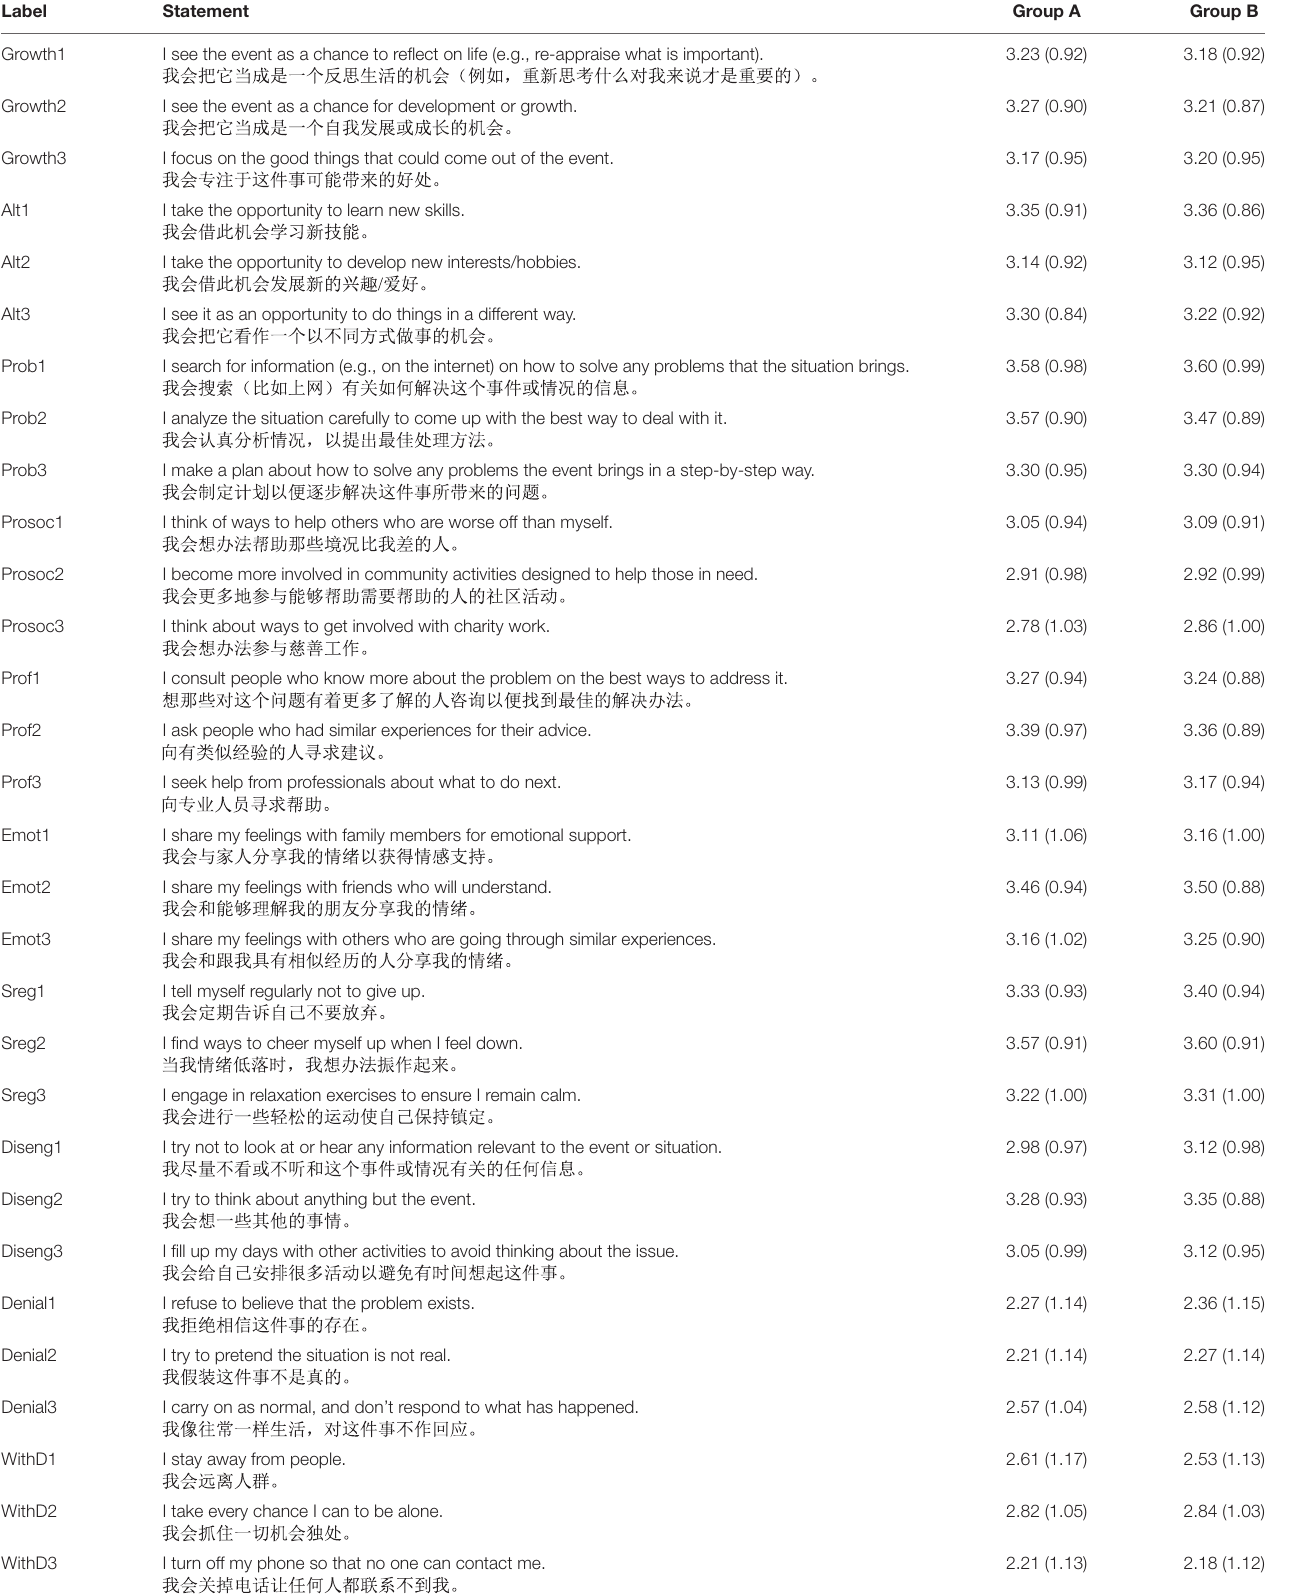
TABLE 1 | Item statements and descriptive statistics (Groups A and B, n = 734) for the coping strategies scale (CSS) and validation instruments. Label Statement Group A Group B